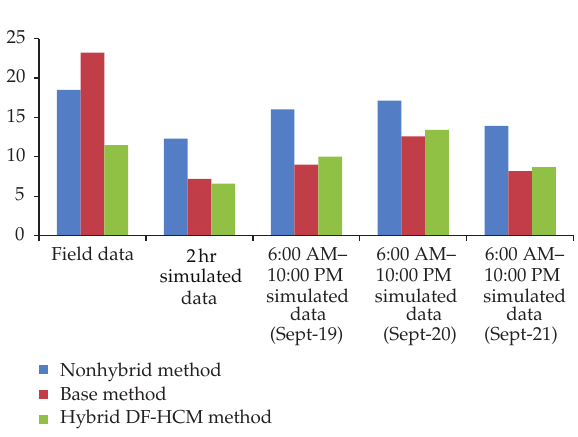
Figure 6: Performance of models in terms of MAPE for field and simulated data.